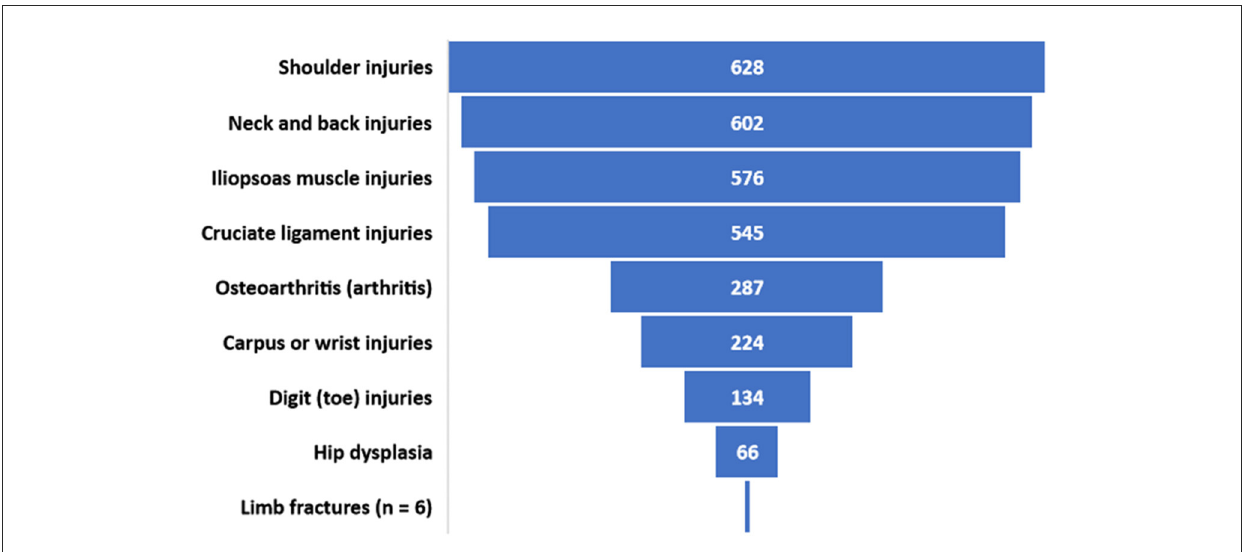
FIGURE3 Number of respondents who included each type of musculoskeletal injury or problem in their designation of up to 3 priority research recommendations.